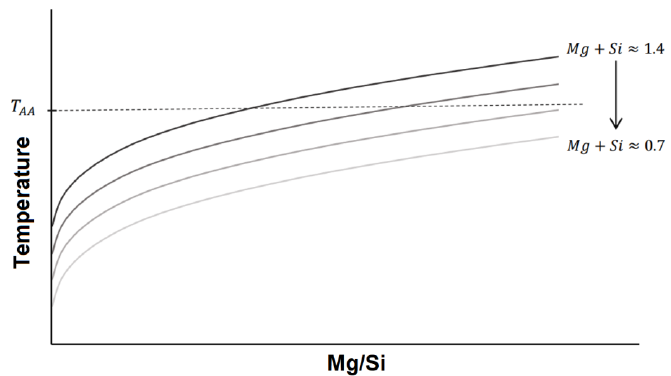
Figure 22. Illustration of proposed compositional dependence of NA cluster stability for varying Mg + Si and Mg/Si contents.